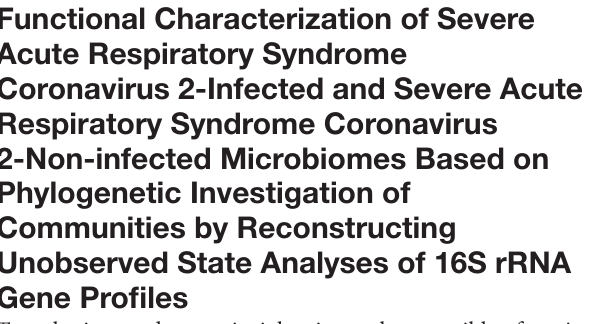
To further investigate the association between the gut microbiomes and COVID-19 viral load, we performed Spearman’s rank-order correlation between the viral load in nasal and stool samples to the relative abundance of the gut microbiome, which demonstrated a lack of significant association ( Supplementary Table 3 ). When categorizing viral load into a bivariate categorical group, where a high viral load is defined as the viral load (genome copied/ µ l) being above the median (IQR) cycle threshold value for the detection of SARS-CoV-2 using quantitative reverse-transcription PCR (median: 31.76). There was no significant association between high vs. low SARS-CoV-2 viral load on any of the bacterial microbiome ( Supplementary Table 4 ) when running an independent T -test to measure association ( p <